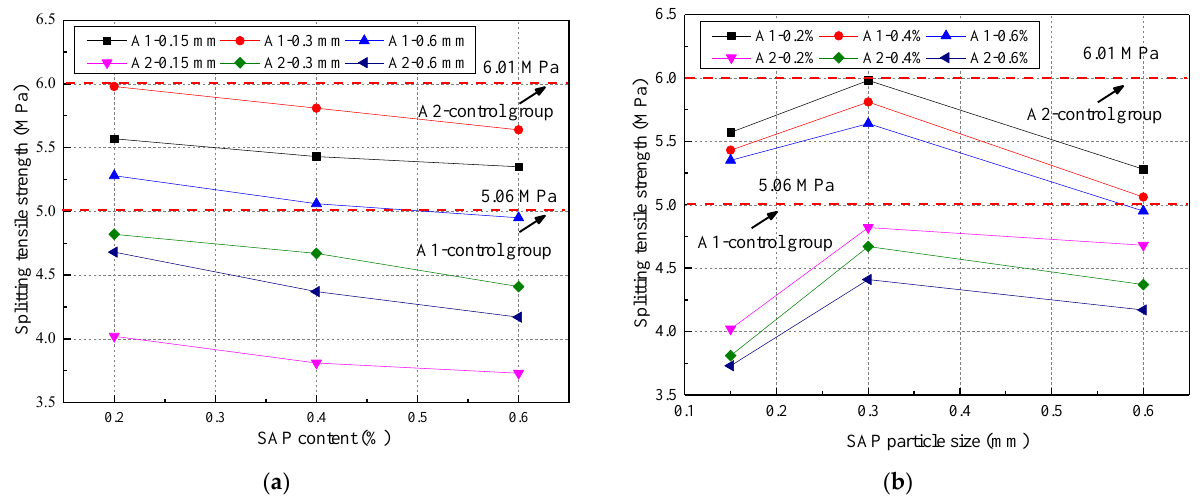
Figure 9. Splitting tensile strength of concrete under two water–cement ratios: ( a ) different SAP content; ( b ) different SAP particle size.